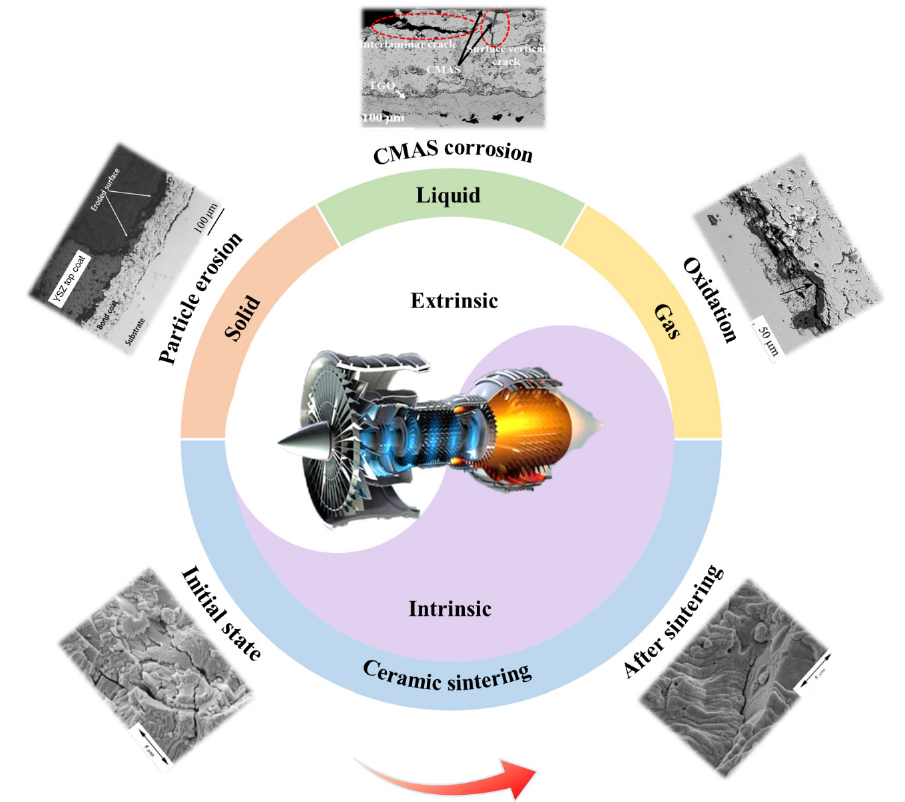
Fig. 4 TBC failure caused by extrinsic (particle erosion, CMAS corrosion, oxidation, etc.) and internal factors (ceramic sintering) under the actual service environment. Reproduced with permission from Ref. [29], © ASM International 2004; Ref. [40], © Society for Experimental Mechanics 2020; Ref. [41], © ASM International 2017; Ref. [42], © ASM International